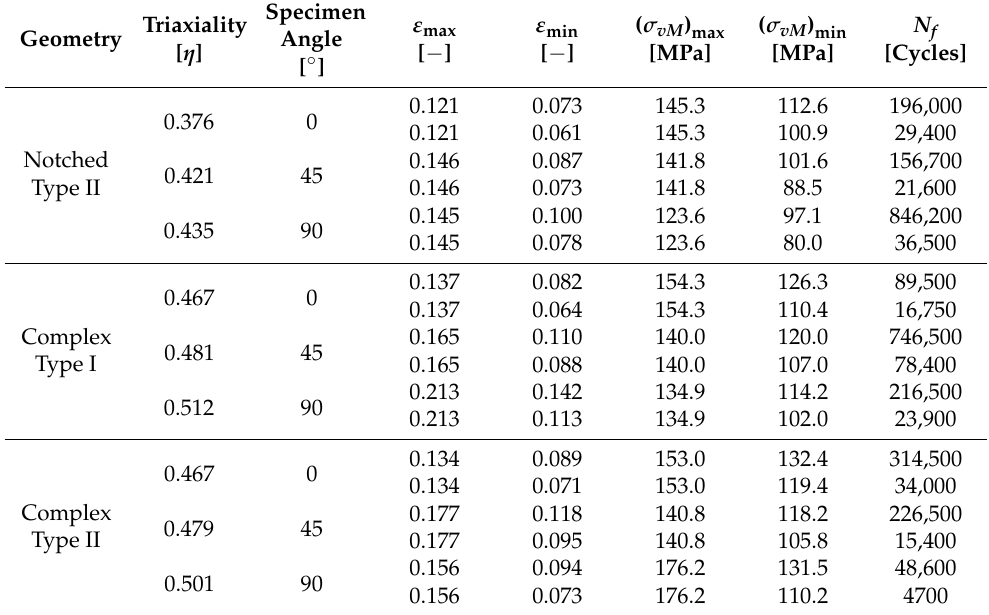
Figure 10. The XCT images from PA6-CF injection molded plate. Fibers and matrices appear as white and grey elements. ( a ) Full 3D view of a single XCT data. ( b ) Surface and core layer along thickness and injection direction. ( c ) Surface layer view from normal to the thickness direction. The image is converted into coordinate data in pixel units through the Open_Ai open source tool. Three-dimensional data are stored as a three-dimensional coordinate system with a unique ID per pixel. The data of each pixel ID consist of Node ID and fiber vector. Additionally, fiber orientation vectors of T xx , T yy , T zz , T xy , T xz , and T yz are calculated for each Node. The fiber orientation vector is defined with the fiber length l with orientation angles as follows: